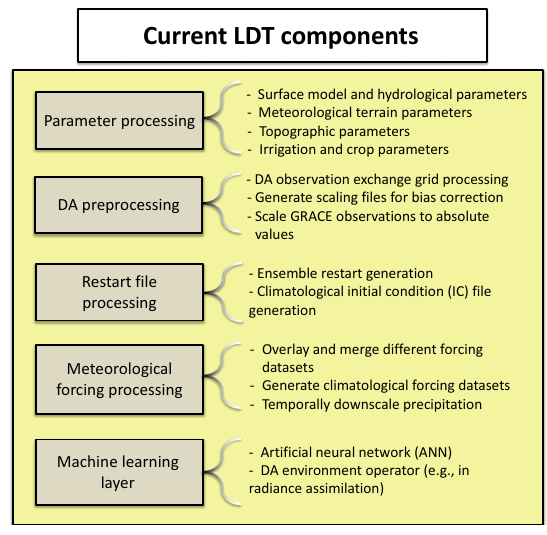
Figure 3. Schematic depicting the current and different components in